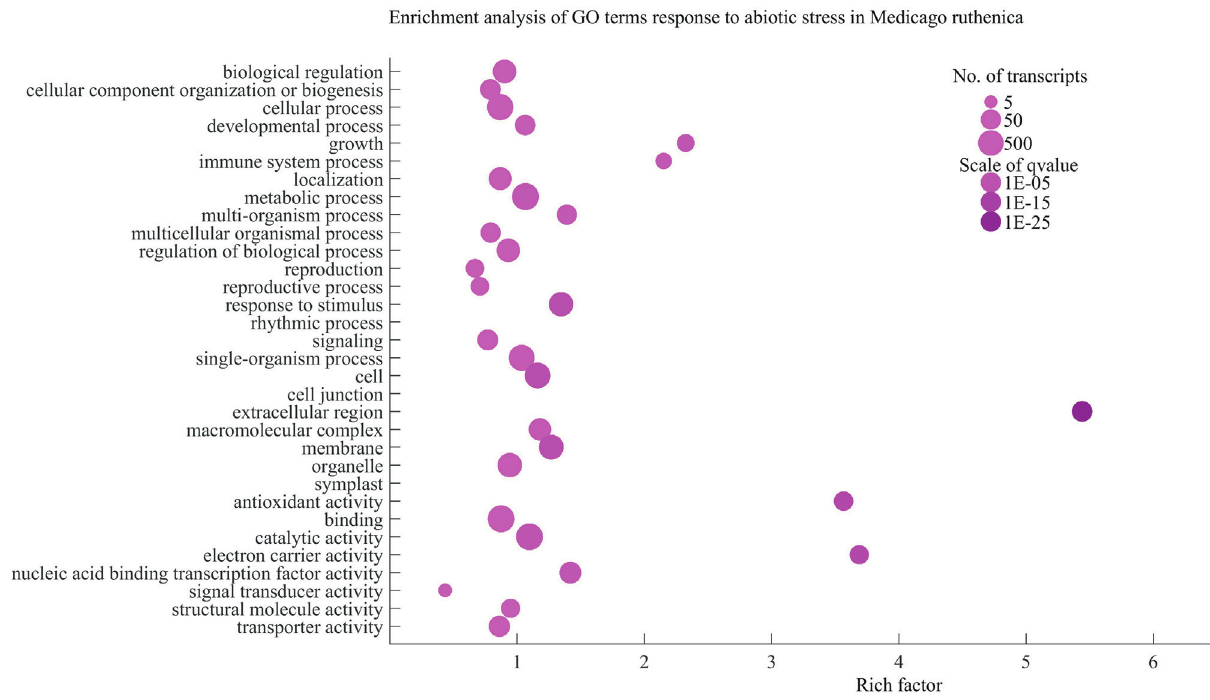
Figure6 -Geneontology(GO)enrichmentanalysisof Medicagoruthenica uniquetranscriptsresponsetoabioticstress.Theenrichedtranscriptsareplot- ted in the various GO terms as pink circles, and the sizes of the circles indicate the relative number of transcripts present in each GO term. The color scale is based on p -value. Dark pink circles are the most significantly over-represented, while light pink circles represent the least significant